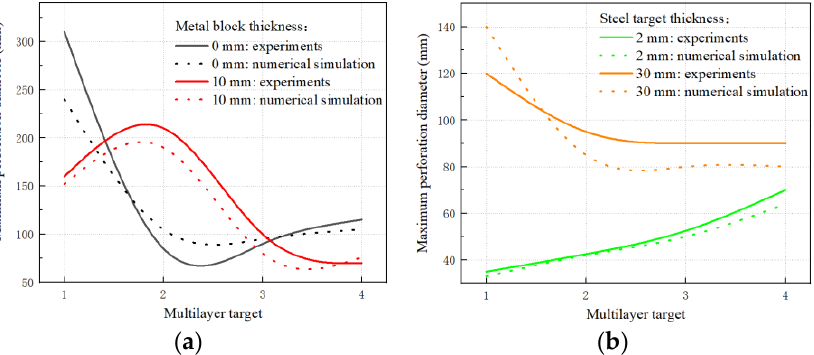
Figure 19. Numerical simulation validation: ( a ) Metal block thickness and ( b ) Steel target thickness.